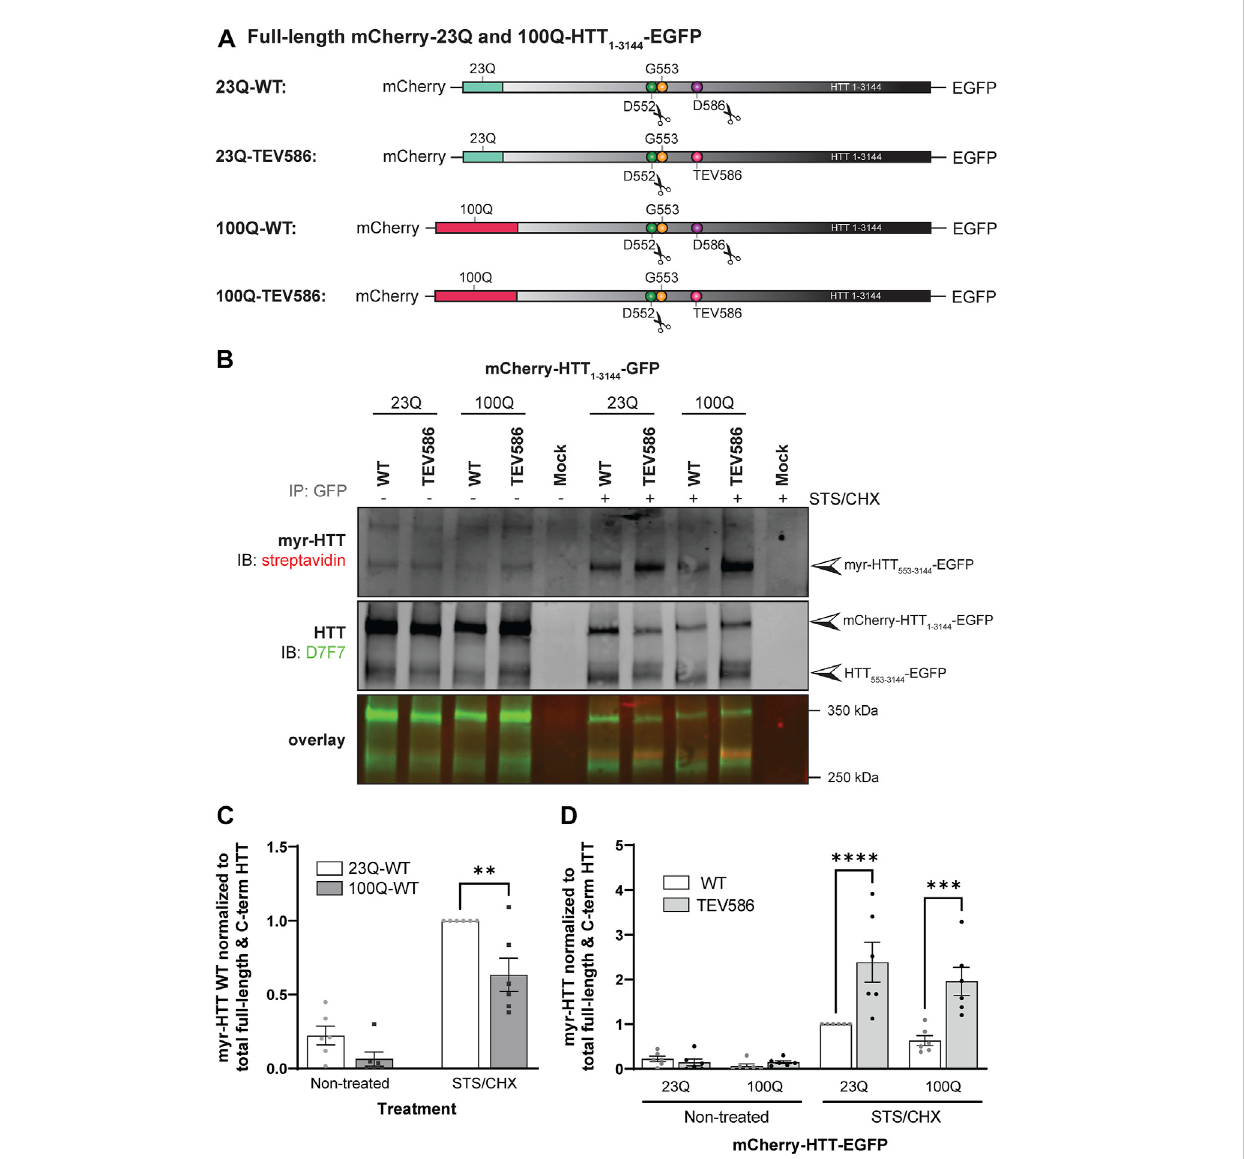
FIGURE 5 Myristoylation of C-terminal HTT 553-3144 is reduced in the presence of the HD mutation, and increased when proteolytic cleavage of full-length huntingtin at D586 is impaired. (A) Schematic representation of the full-length mCherry-23Q and 100Q-HTT 1-3144 -EGFP constructs WT, or with the D586 caspase cleavage site replaced with a Tobacco Etch Virus proteolytic site (TEV586). The scissor symbols indicate the D552 and D586 cleavage sites, (B) HeLa cells were transfected with mCherry-23Q and mCherry-100Q-HTT 1-3144 -EGFP constructs WT or TEV586. Cells were metabolically labeled with 100 µM alkyne-myristate for 30 min in the absence or presence of 1 µM staurosporine and 5 μ g/mL cycloheximide (STS/CHX) for 4 h to promote proteolysis and inhibit protein synthesis, respectively. Full-length and C-terminal HTT fragments were immunoprecipitated from cell lysates using goat anti-GFP antibodies. The myristate analog was covalently linked to biotin azide through click chemistry. Myristoylated HTT 553-3144 -EGFP orthogonally labeled with biotinwasdetectedwithstreptavidinandtotalHTTwasdetectedwithHTTantibodies(D7F7).ArrowheadsindicatemyristoylatedHTT(myr-HTT 553-3144 -EGFP) in the top panel, total C-terminal HTT (HTT 553-3144 -EGFP) and full-length HTT (mCherry-HTT 1-3144 -EGFP) in the middle panel, (C) myristoylation of HTT is reduced in the presence of the HD mutation. Myristoylation levels of HTT were quanti fi ed as the ratio of myristoylated HTT (myr-HTT 553-3144 -EGFP) normalized to the sum of full-length HTT (mCherry-HTT 1-3144 -EGFP) and C-terminal HTT fragments (HTT 553-3144 -EGFP), and expressed relatively to myristoylation of 23Q-HTT WT in cells treated with STS (n = 6), (D) Myristoylation of HTT is signi fi cantly increased when D586 cleavage of full-length HTT is impaired.MyristoylationofHTTwasquanti fi edastheratioofmyristoylated HTTnormalizedtothesumoffull-lengthHTTandC-terminalHTTfragments, and expressed relatively to myristoylation of 23Q-HTT WT in cells treated with STS (n = 6). Statistical analysis : (C) 2-way ANOVA: interaction, p = .15; STS/CHX treatment, **** p < .0001; HD mutation, ** p = .0011. Sidak ’ s multiple comparison test, ** p = .0025. (D) 3-way ANOVA: WT vs. TEV586, **** p < .0001; Non- treated vs. STS/CHX, **** p < .0001; 23Q vs. 100Q, p = .10. Sidak ’ s multiple comparison test (WT vs. TEV586), **** p < .0001, *** p < .0001.2-way ANOVA (TEV586 constructs only): interaction, p = .44; Non-treated vs. STS/CHX, *** p < .0001; 23Q vs. 100Q, p =